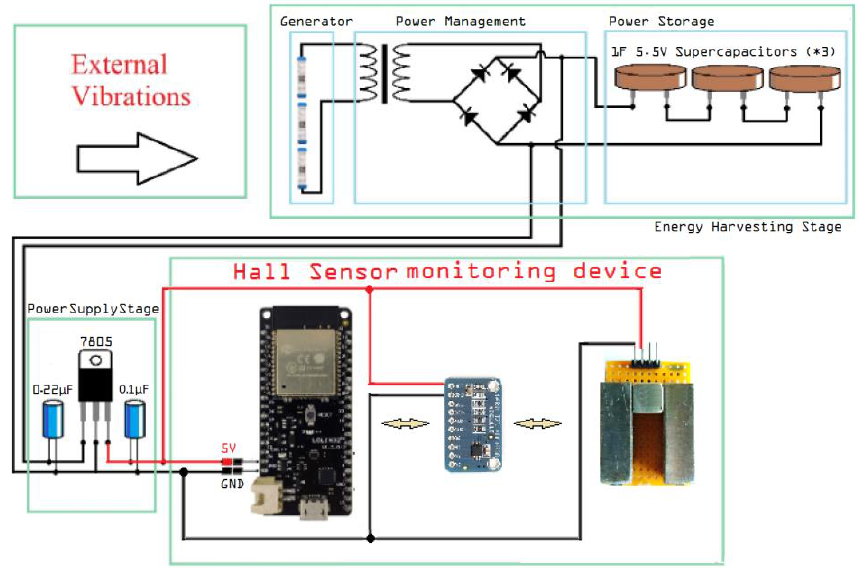
Figure 15. Autonomous Hall-effect sensor system overview.